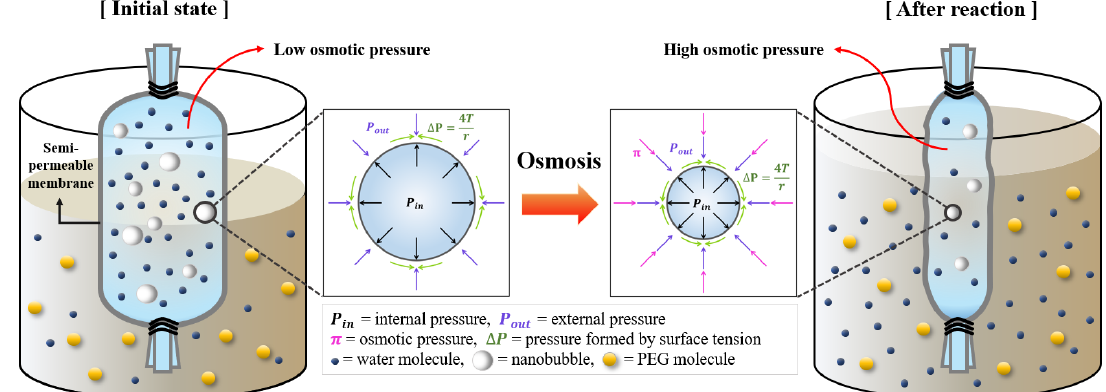
Figure 2. Effects of osmosis on the bubble size and state.